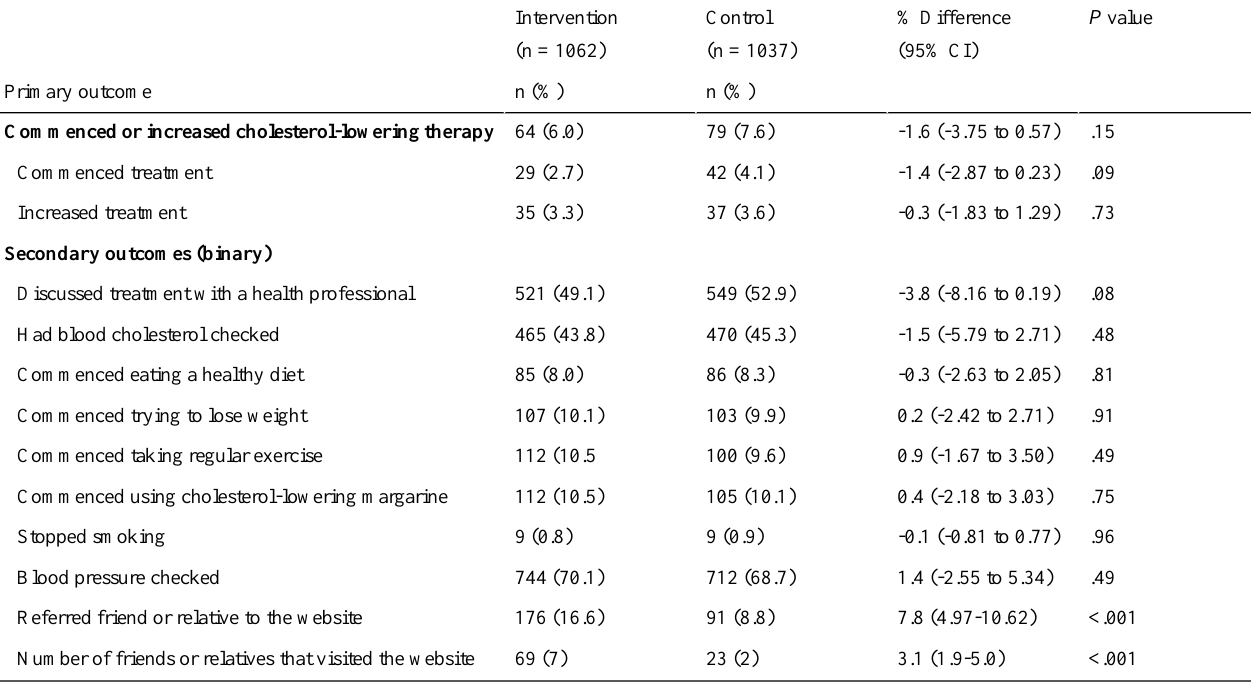
Table 2. Effects of treatment on primary and secondary outcomes (binary) among randomized participants